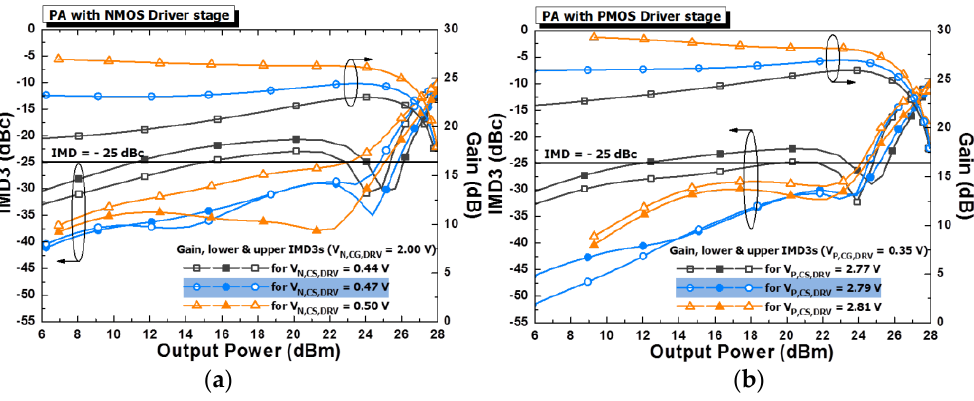
Figure 8. Simulated IMD3 and gain with various common-source bias voltages (V DD = 3.3 V, V N,CG,DRV = 2.00 V, and V P,CG,DRV = 0.35 V): ( a ) typical NMOS driver stage, ( b ) proposed PMOS driver stage.